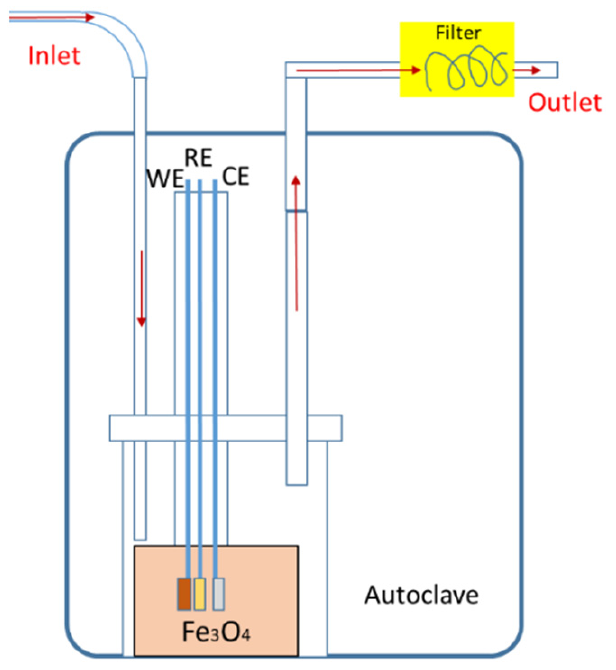
Figure 2. Scheme of the measurement setup.